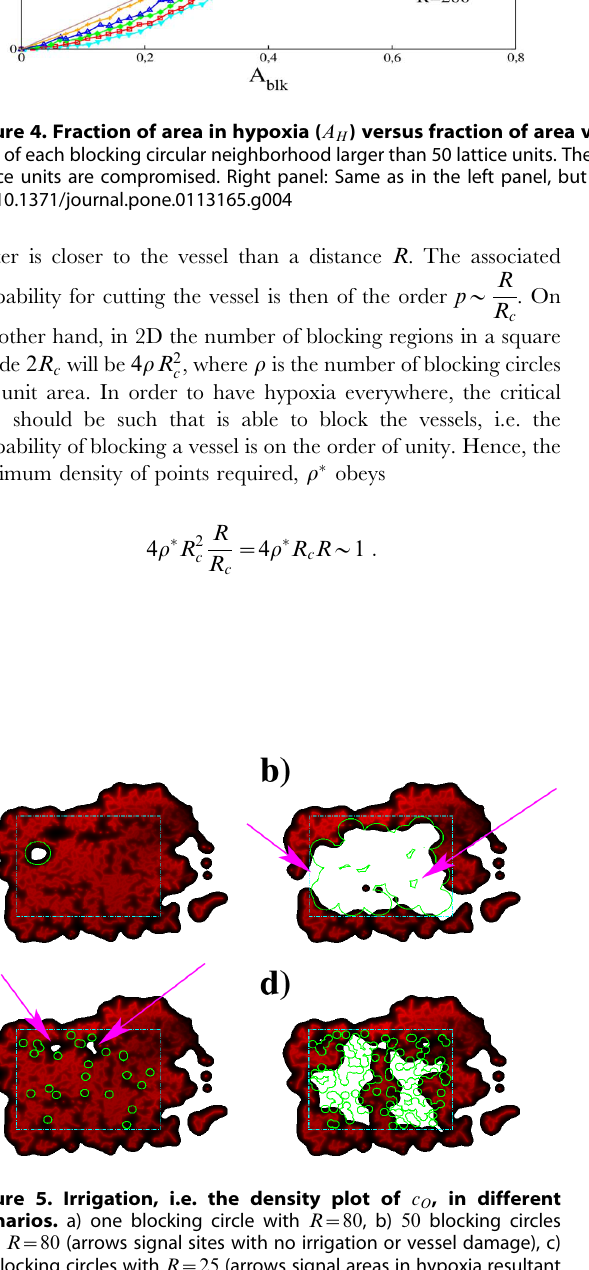
Figure 6. In black circles, the logarithm of inflexion points, from curves showed in Fig. 4, versus the logarithm of R . We compare to two straight dashed lines with slope 1 and 0. We observe * R for R much smaller than R c that the transition points follow A (cid:2) blk * O (1) for R w R c . In red squares the same for L ~ 8 lattice and A (cid:2) blk units.